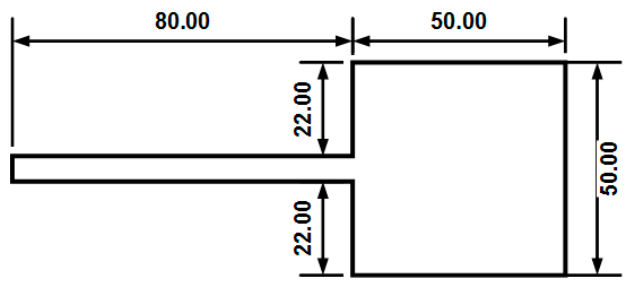
Figure 3. Parameters of the T-type probe (dimensions in mm).